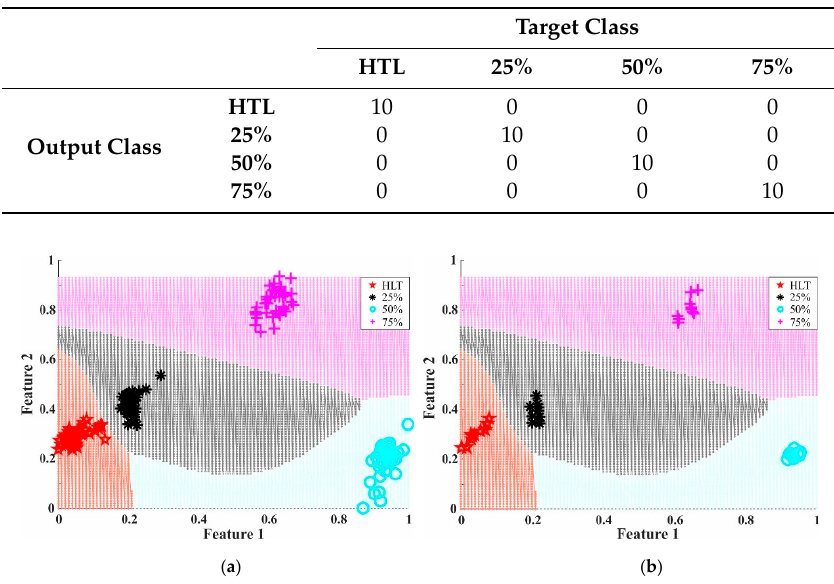
Figure 7. Resulting projection of the classification regions obtained during the identification of uniform wear in gearbox gears by means of the ANN-based classifier: ( a ) training procedure and ( b ) validation